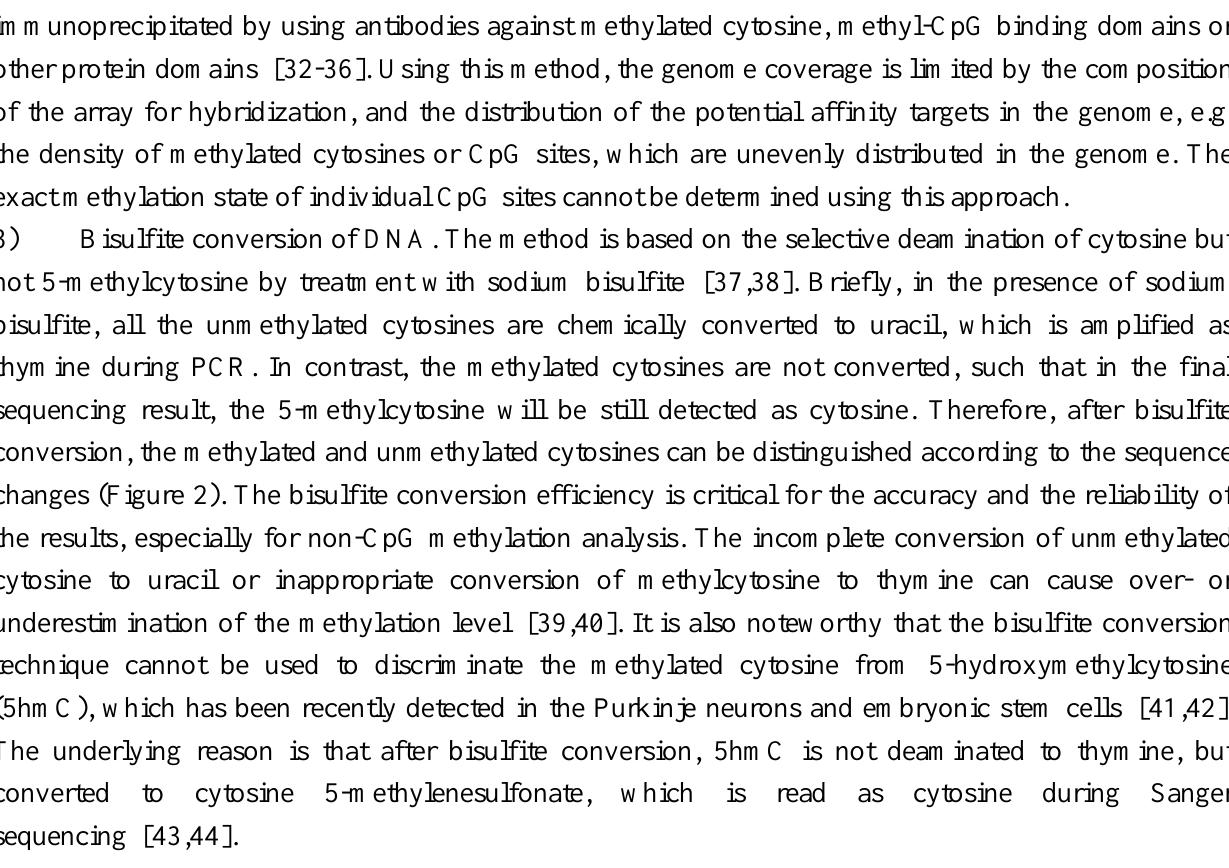
Figure 2. Example of the bisulfite sequencing result of a single read. After bisulfite